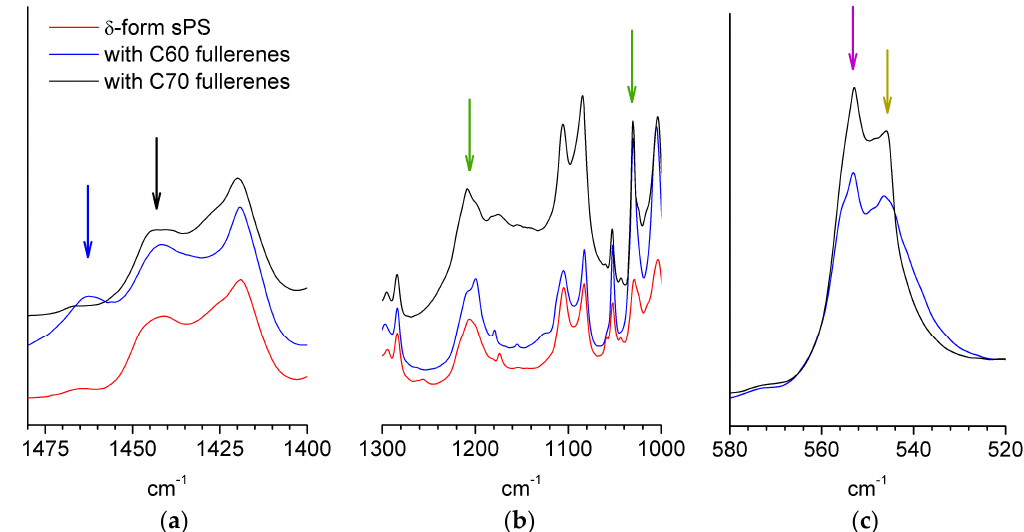
Figure 2. FTIR spectra from different synditoactic polystyrene (sPS) films: δ -form (red line), sulfonated and loaded with C60 fullerenes (blue line); sulfonated and loaded with C70 fullerenes (black line). The region where additional infrared ands to those from the polymer film are observed (blue and black arrows) is shown in panel ( a ), while the IR bands from the sulfonic ionic group (green arrows) are shown in panel ( b ). Panel ( c ) shows the bands characteristic of sPS: the arrows indicate the peaks that were considered to correspond to chain conformations in crystalline (purple) and amorphous (dark yellow) phases.